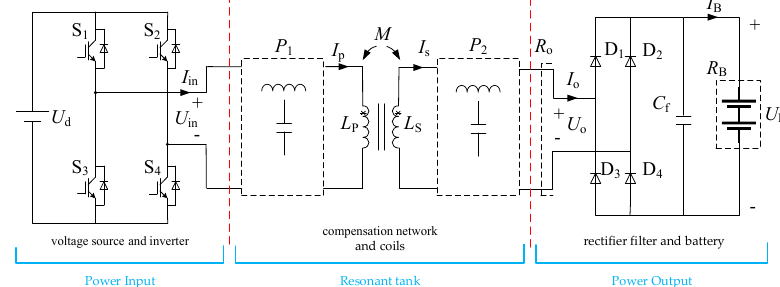
Figure 1. Wireless battery charging system.